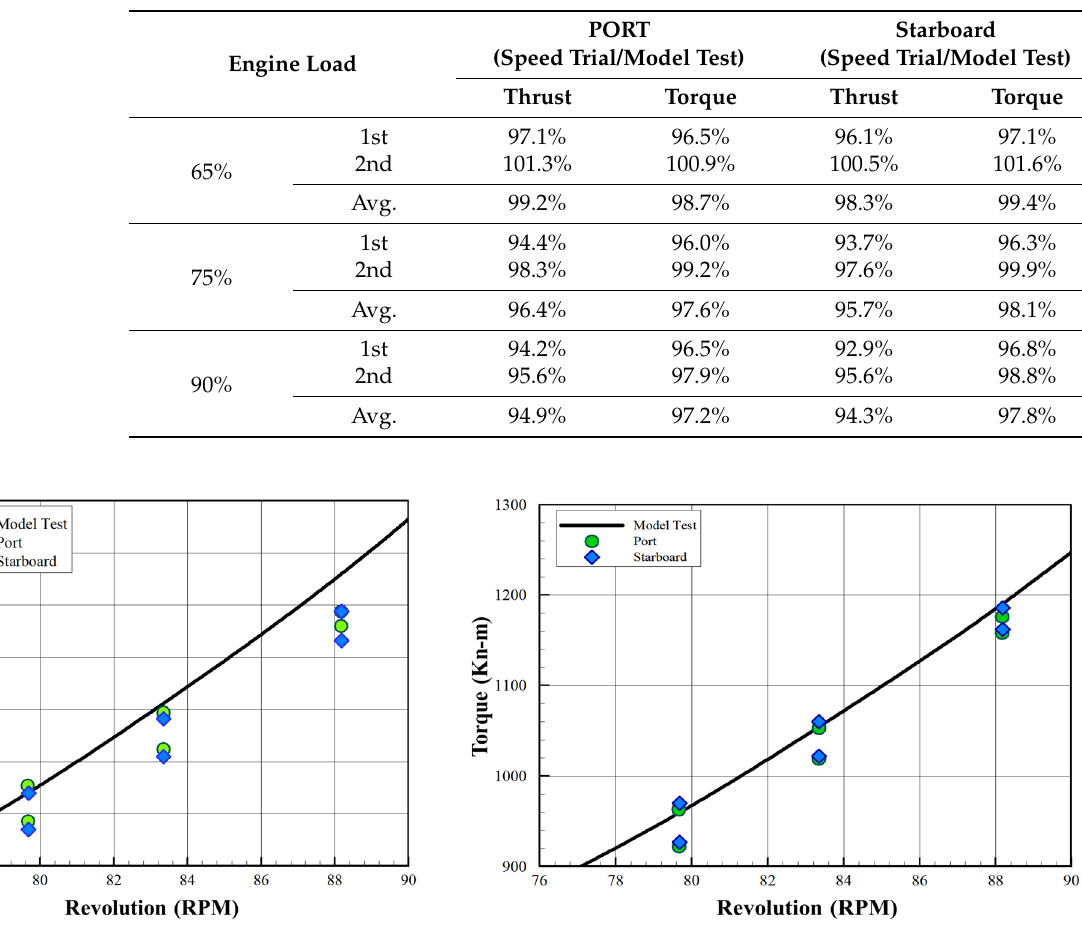
Figure 9. Comparison of thrust and torque between speed trials and prediction results based on the model test of the twin skeg LNG carrier.